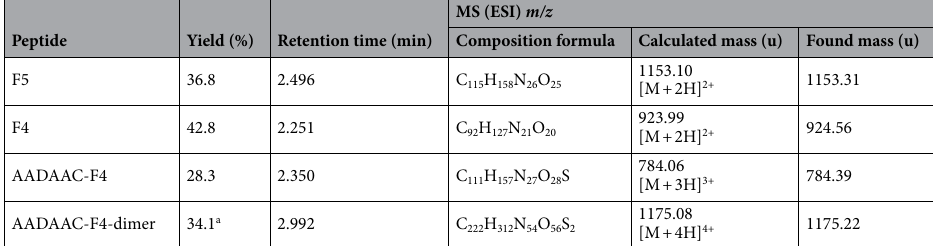
Table 1. Fn analogues synthesized in this study. Retention times of each peptide were determined by RP-UPLC-MS. a Yield when 50.64 mg of AADAAC-F4 was used as a raw material.